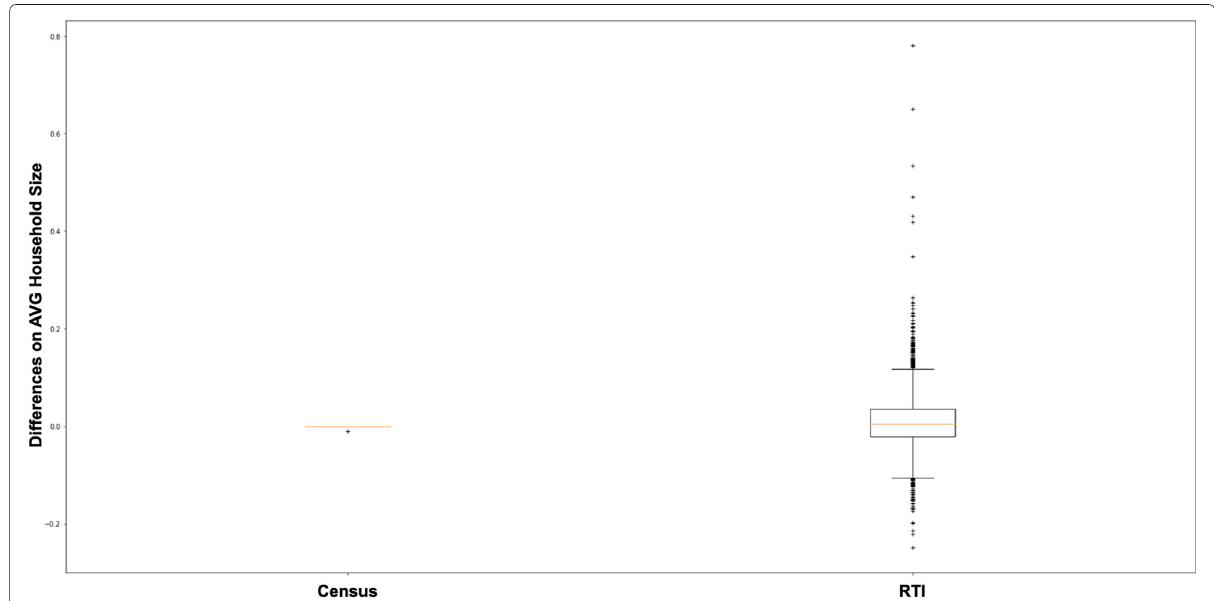
Fig. 8 Comparison of Differences Between Our Synthetically Generated Average household size with the Census and RTI Synthetic Data